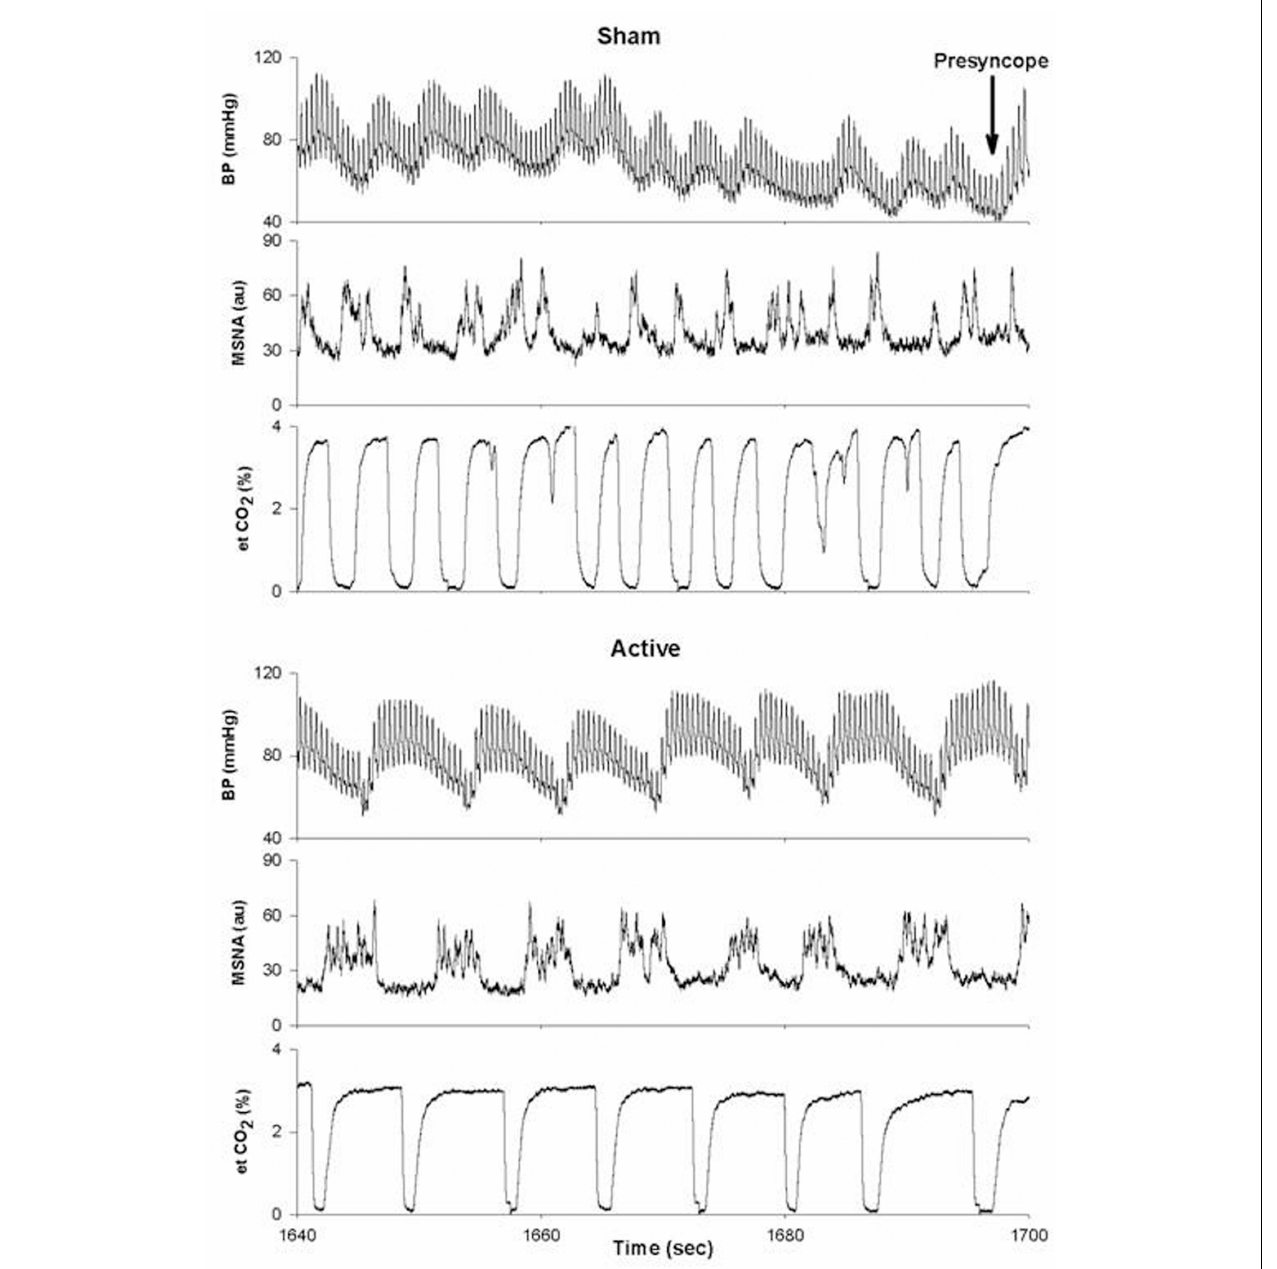
FIGURE 6 | Blood pressure (BP), muscle sympathetic nerve activity (MSNA) and end-tidal CO 2 (et CO 2 ) tracings for a single subject under conditions of breathing with a sham (top) or active (bottom) device that provided resistance to inspiration. Au, arbitrary units. From Ryan et al. (2008).